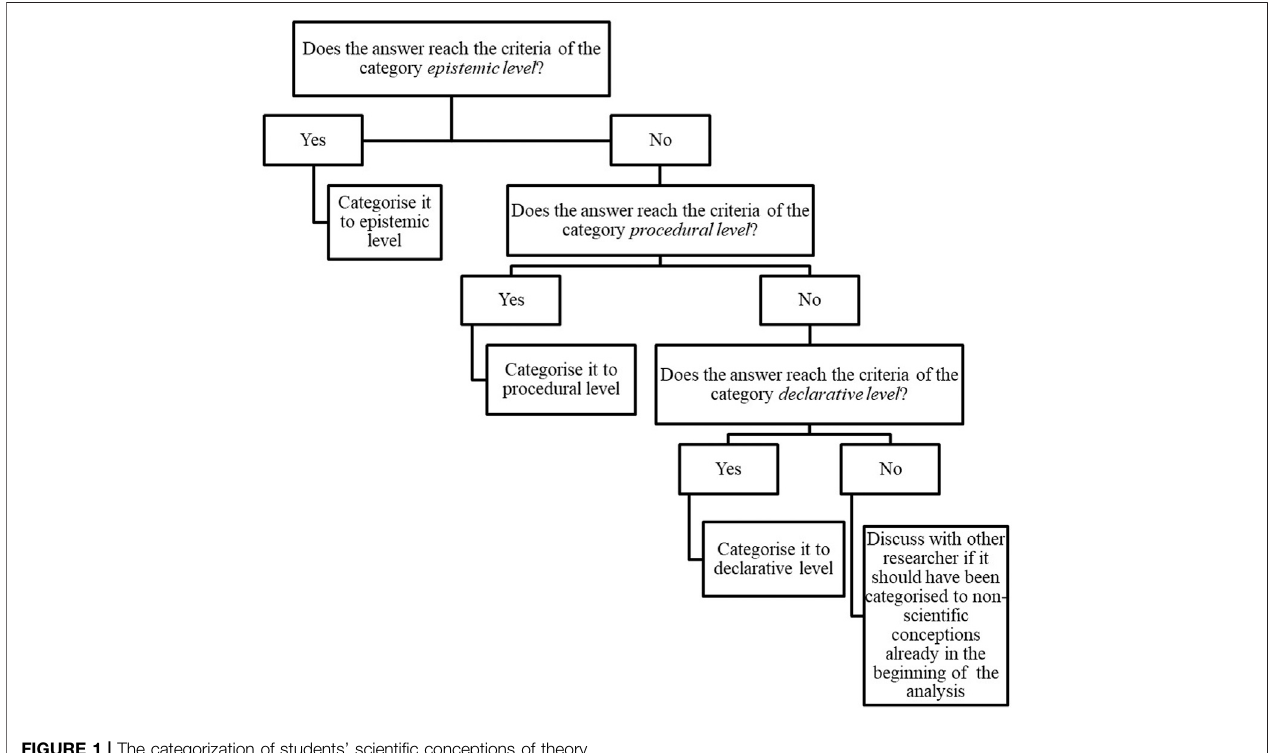
FIGURE 1 | The categorization of students ’ scienti fi c conceptions of theory.